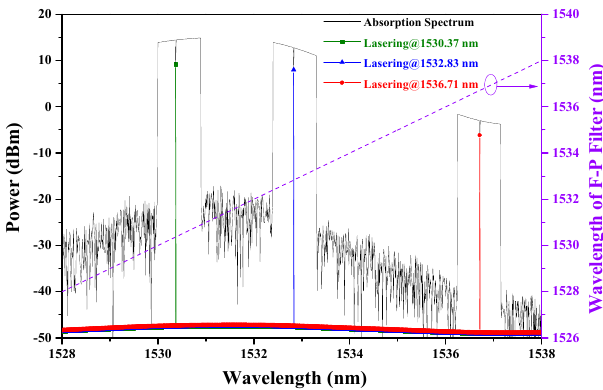
Figure 7. Calculated absorption spectra and laser spectra via tuning the F–P filter.